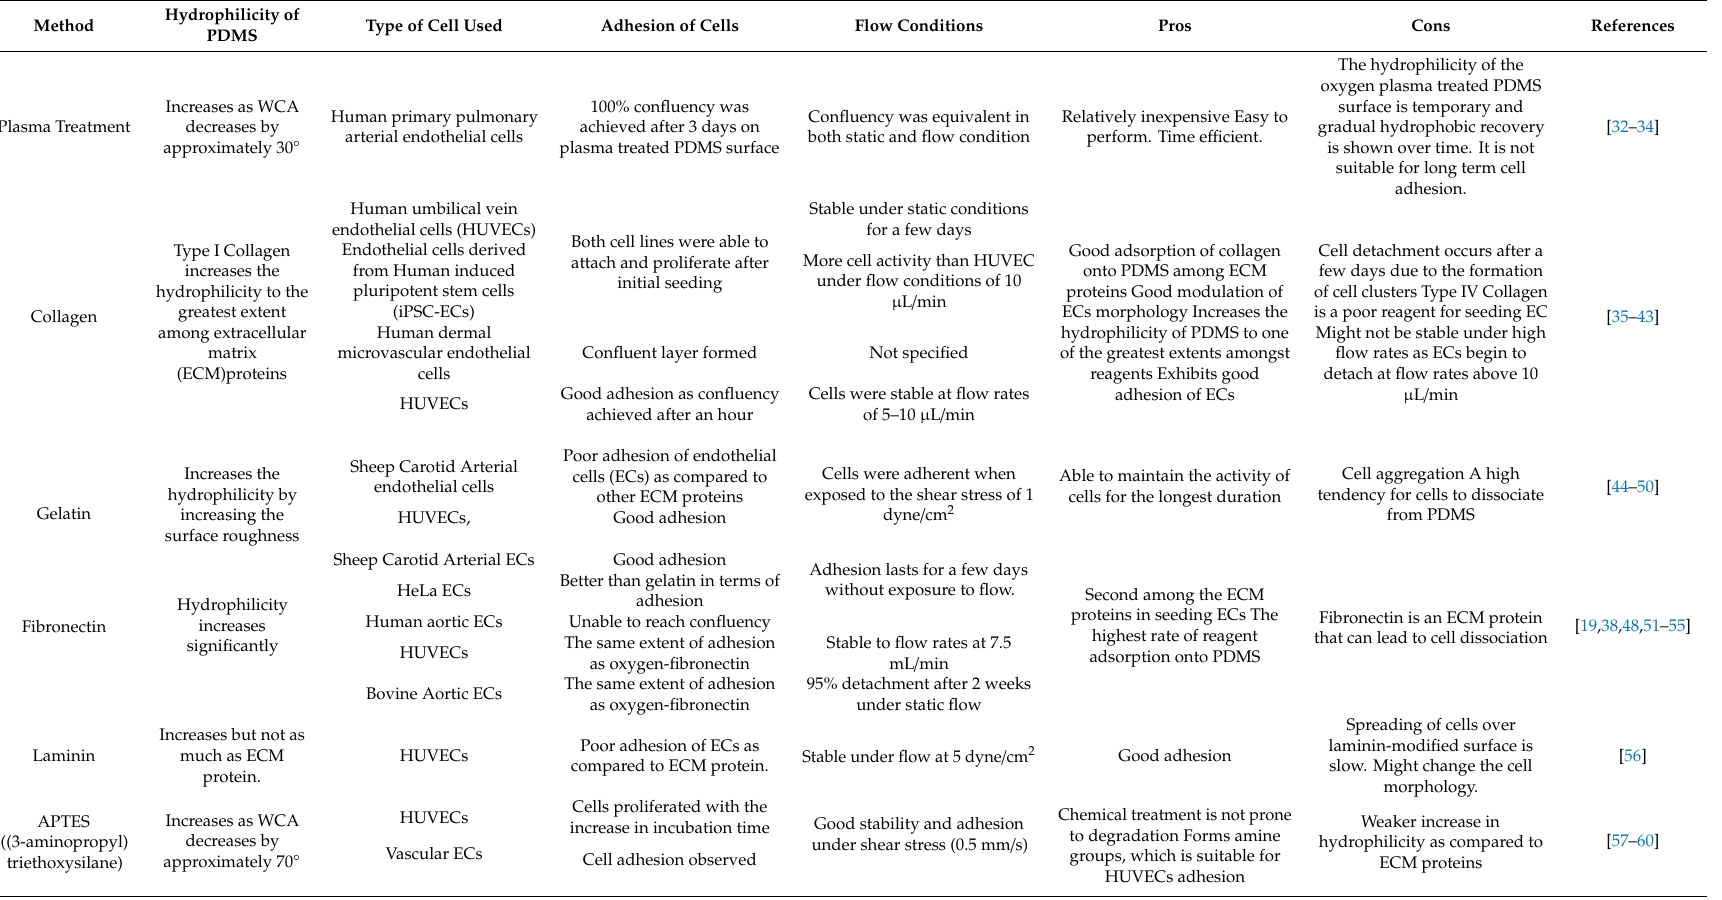
Table 1. Summary of the extensively used PDMS surface modification treatment for improving cell